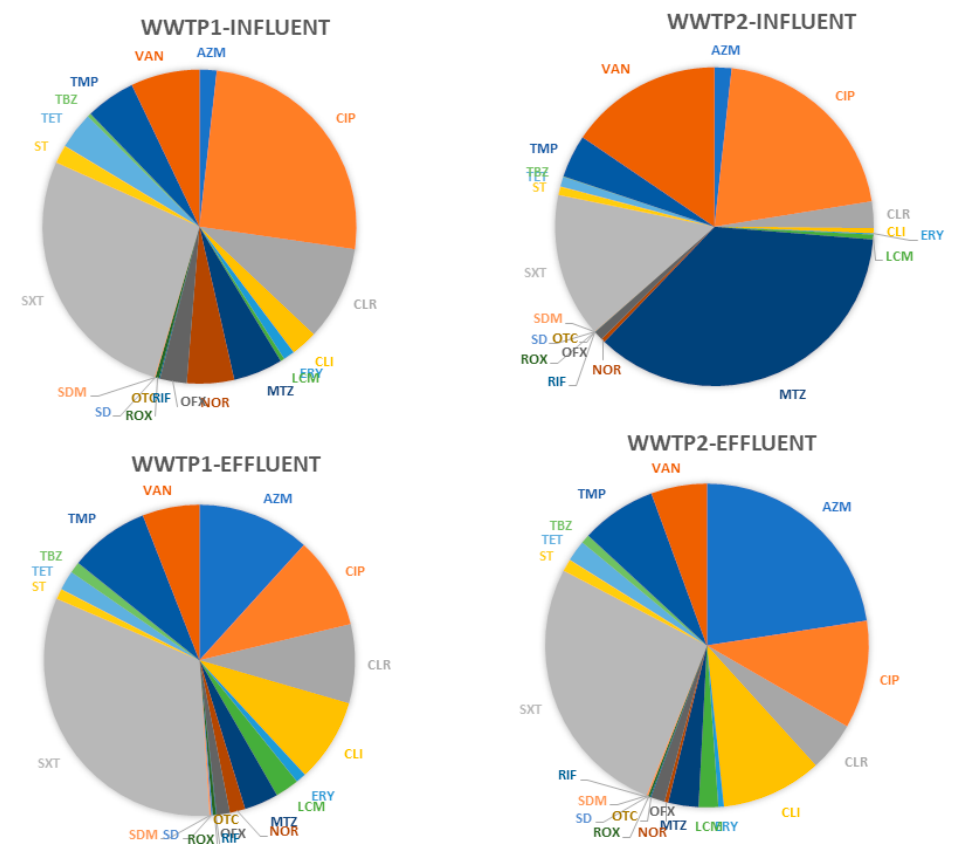
Figure 1. Percentage contribution (%) of tested antimicrobials in influent and effluent of both WWTPs, n = 3.